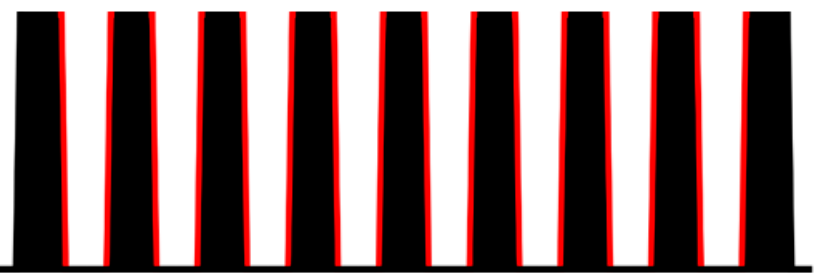
Figure 14. Fins’ surfaces (red) whose radiative heat transfer coefficient needs to be adjusted due to their mutual radiation.